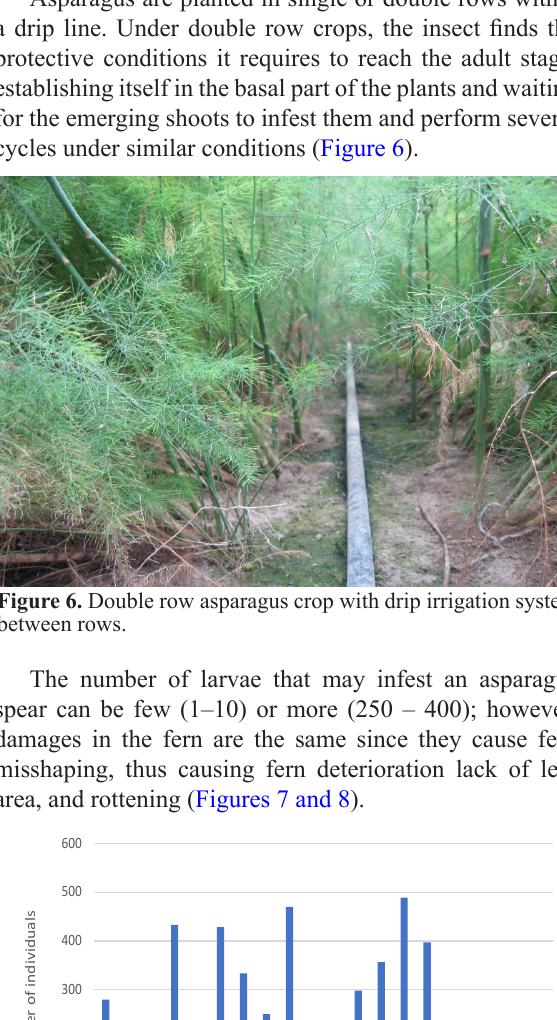
Figure 3. Number of Prodiplosis longifila Gagn é adults captured per night in 100 cm 2 light traps with a sticky surface panel. (2014).